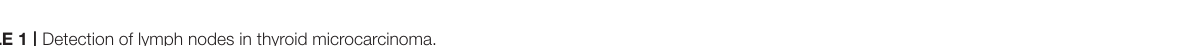
TABLE 1 | Detection of lymph nodes in thyroid microcarcinoma. LN Metastatic Normal distribution Median Metastatic cases Metastasis rate (%) LN